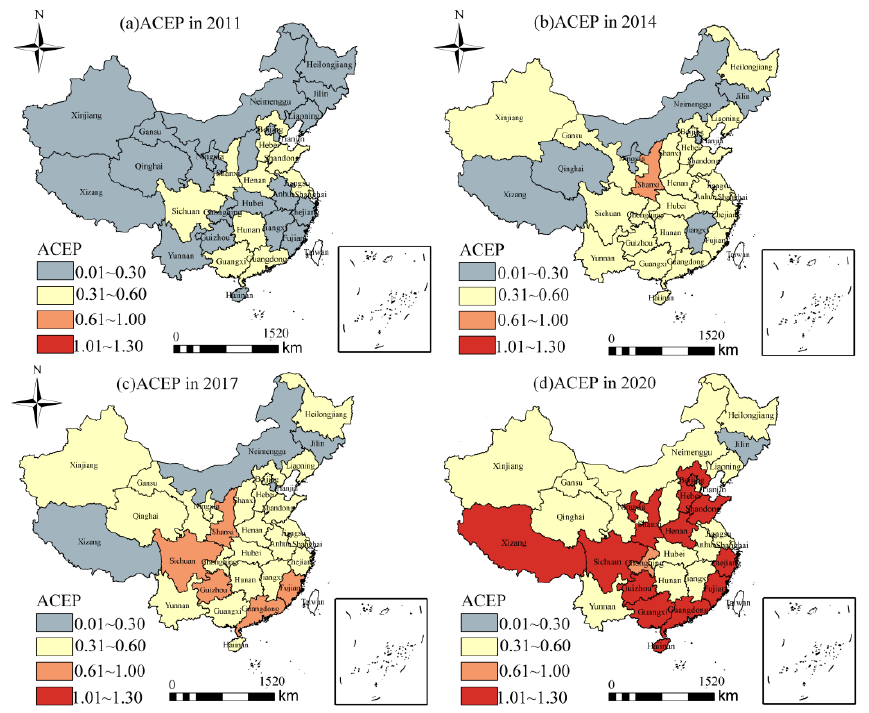
Figure 4. Spatial distribution of ACEP in each province between 2011 and 2020.